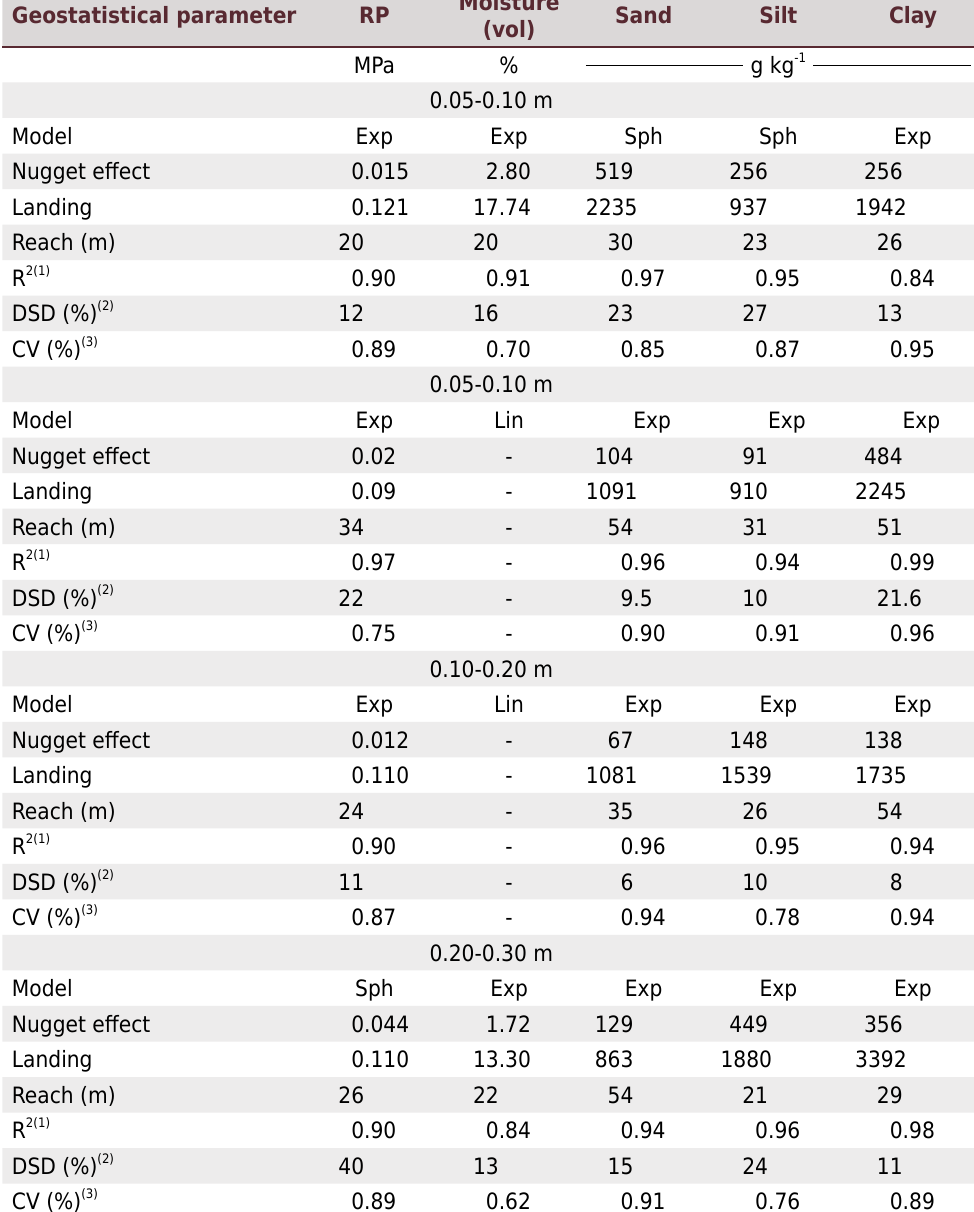
Table 4. Models and estimated parameters for semivariograms of soil resistance to penetration (RP), moisture, sand, silt, and clay for four different layers of Archaeological Dark Earth under cacao cultivation Geostatistical